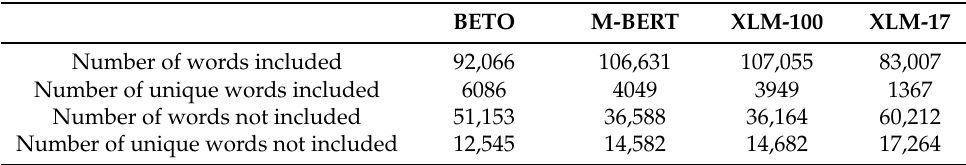
Table 3. SAD vocabulary included in the Transformer-based models.